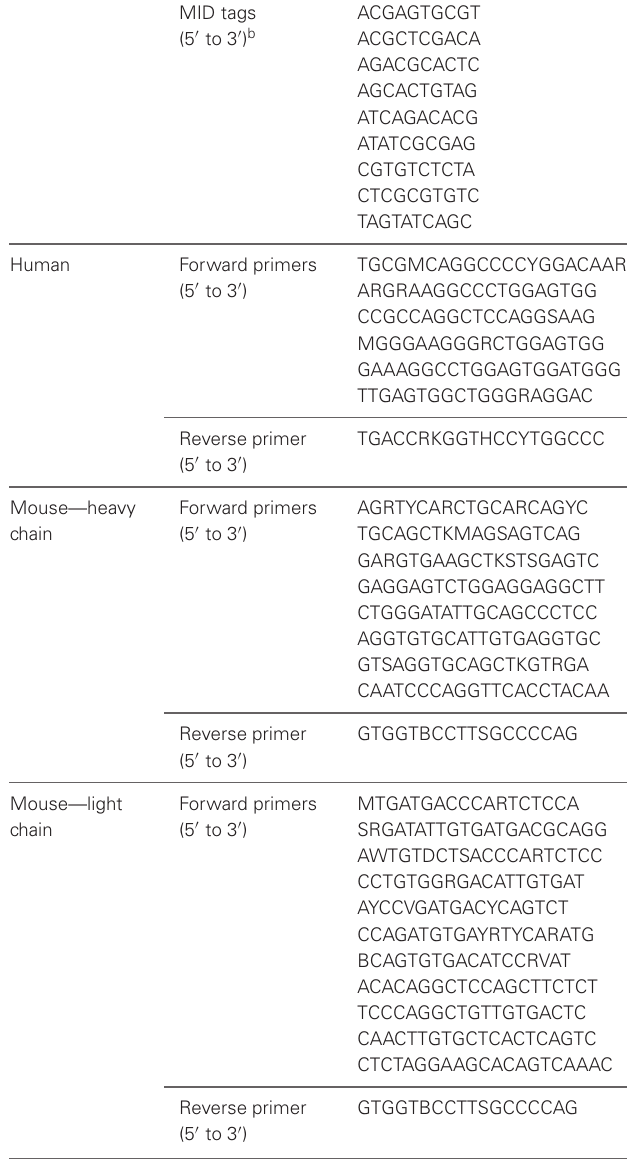
Table 1 | List of MID tags, forward and reverse primers used for Ig-HTS-Cleaner validation a